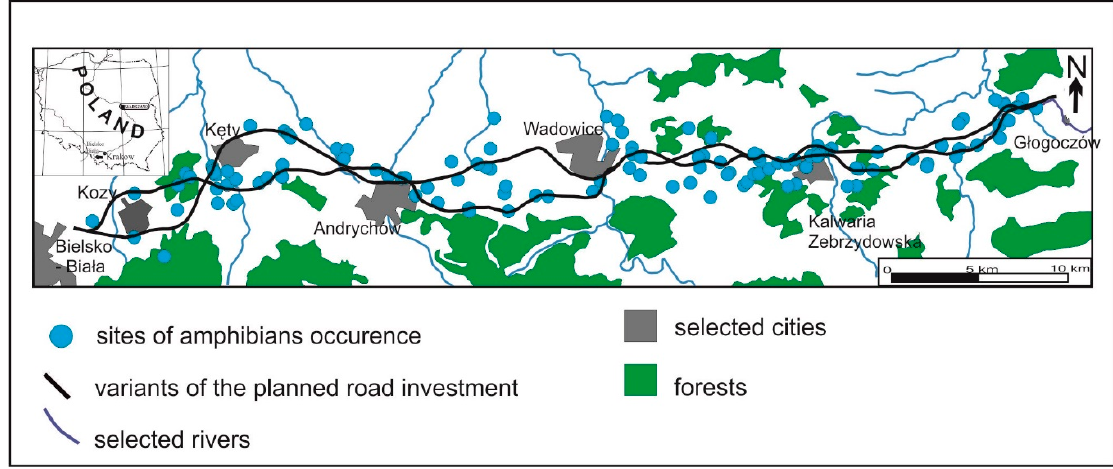
Figure 3. Localization of amphibian occurrence sites along planned s52 expressway.